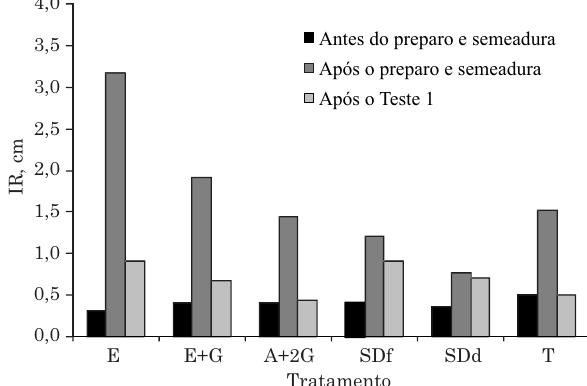
Figura 1. Índice de rugosidade superficial do solo (IR) medido antes e após as operações de preparo e semeadura e após a realização do primeiro teste de erosão (Teste 1) com chuva